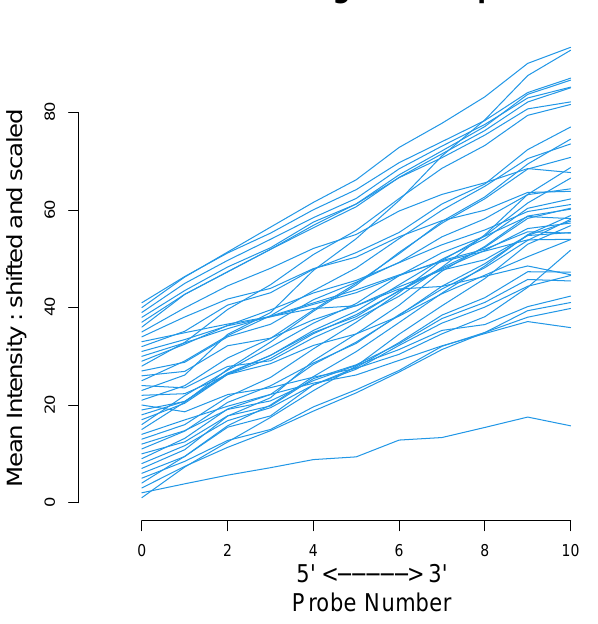
Figure 12. Euler-Venn diagrams comparing the results obtained by the three methods for Dataset A. RNA degradation plot